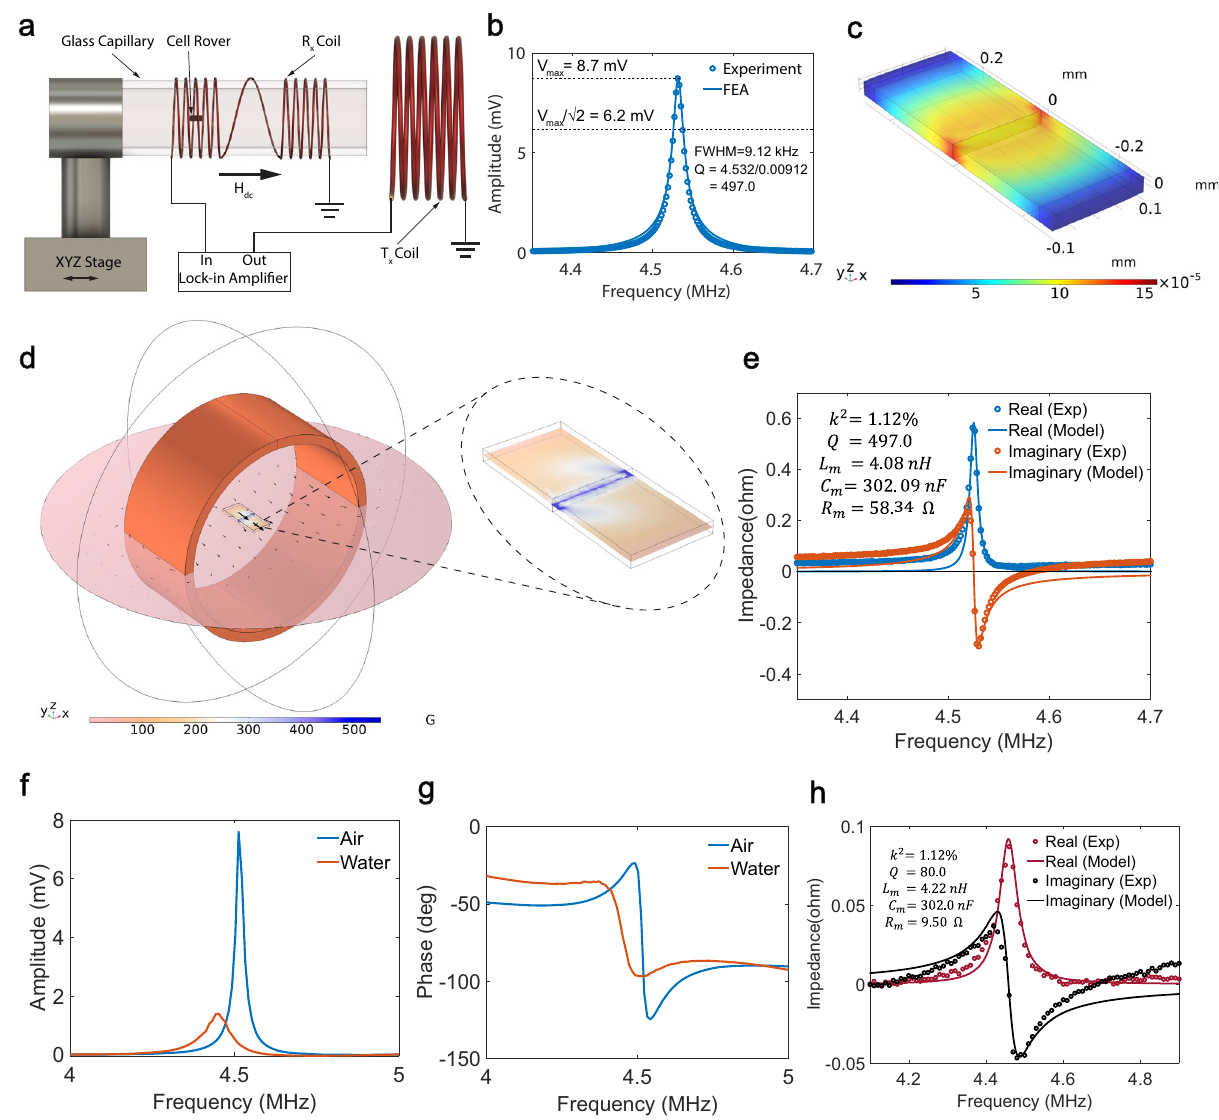
Fig. 2 | Characterization of Cell Rovers in air and water. a Schematic diagram showing the wireless detection of a Cell Rover using a receiving ð R x Þ coil con- sisting of two identical but oppositely wound solenoids connected to a lock-in ampli fi er. The transmission ð T x Þ coil generates the AC excitation magnetic fi eld andapermanentmagnetisusedtoproducetherequiredDCbiasmagnetic fi eld. b Comparison between measured and FEA simulated wirelessly detected vol- tage amplitude from a Cell Rover in air as a function of frequency of excitation magnetic fi eld. The signal amplitude is maximum ð V max Þ at the resonance fre- quency (4.532MHz). The calculation for the quality factor (Q) from the Full Width at Half Maximum (FWHM) is also shown. c FEA simulation of the dis- tribution of strain in the Cell Rover at the resonance frequency (4.532MHz). d FEA simulation showing the magnetic fl ux density distribution in the R x coil containing the Cell Rover at the resonance frequency (4.532MHz). A zoomed in